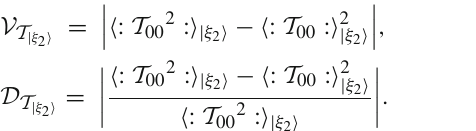
aid of variance of density fluctuations V T and the dimension- less quantity D T defined as: